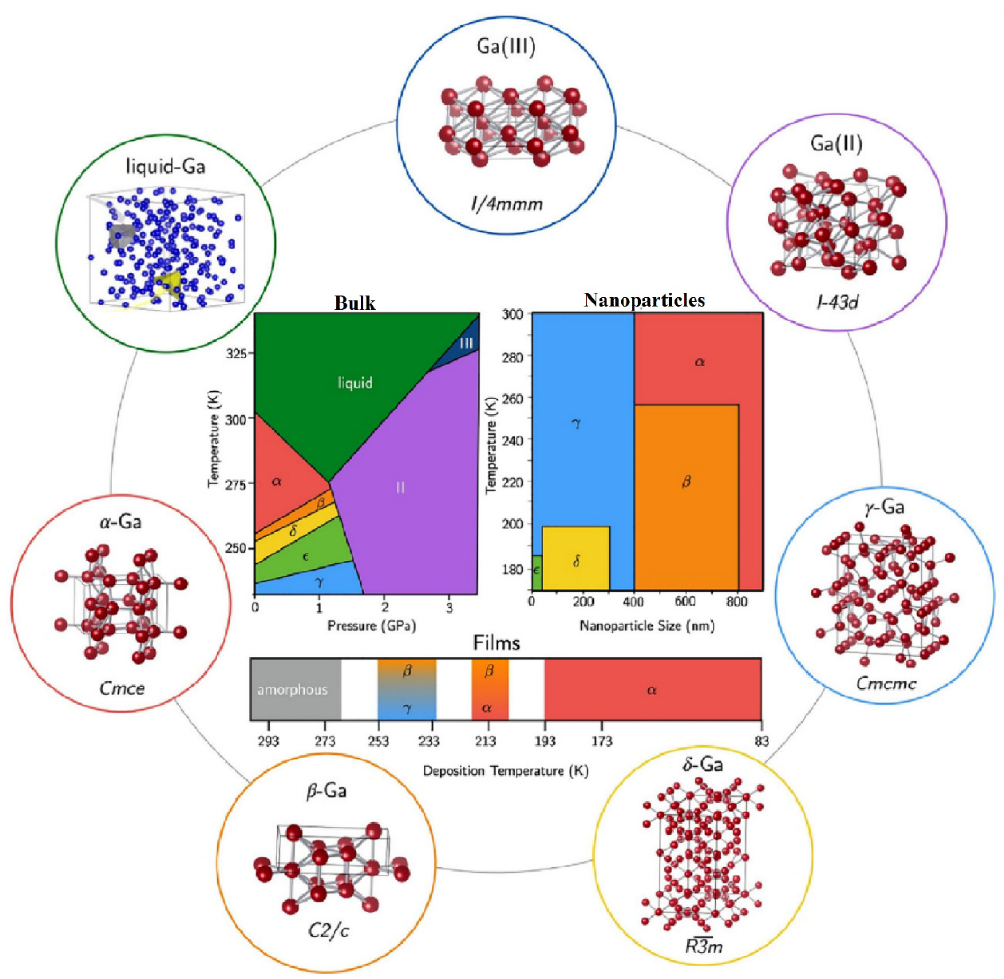
Figure 3. The various structures of gallium oxide and phase diagrams showing various phases at different pressures and temperatures [64]. “Reprinted with permission from Ref. [64]. Copyright (2020), De Gruyter”.